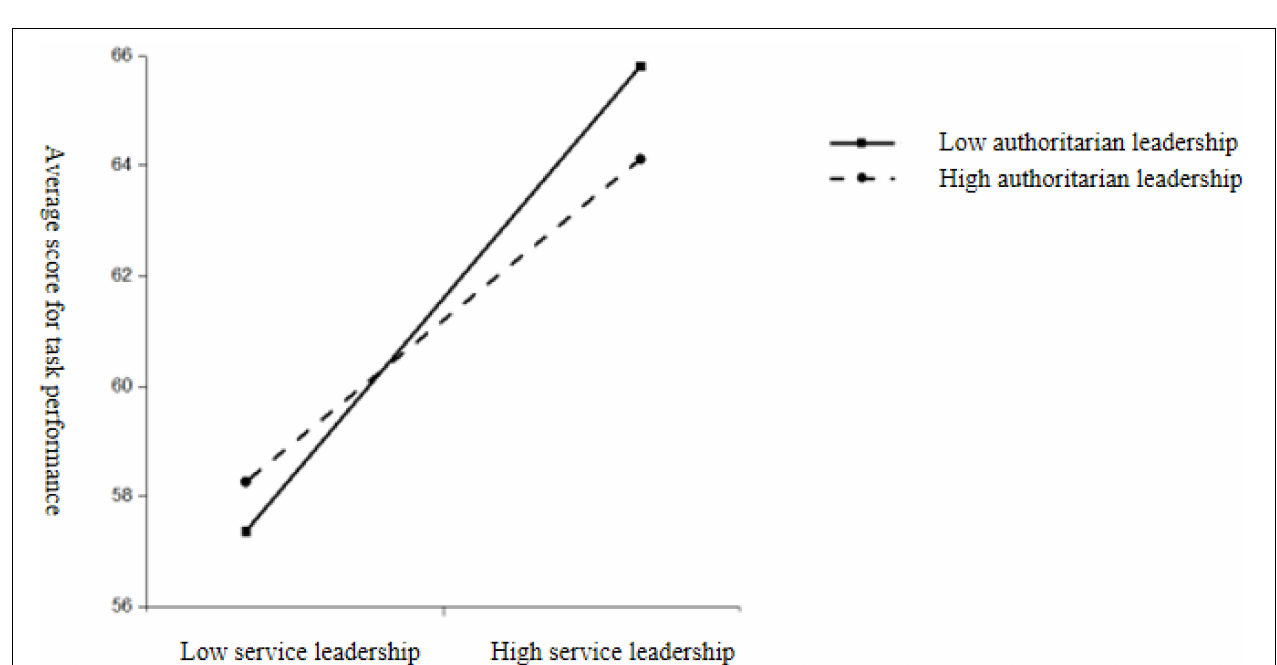
FIGURE 4 | The interaction between authoritarian leadership and servant leadership on organizational citizenship behavior.